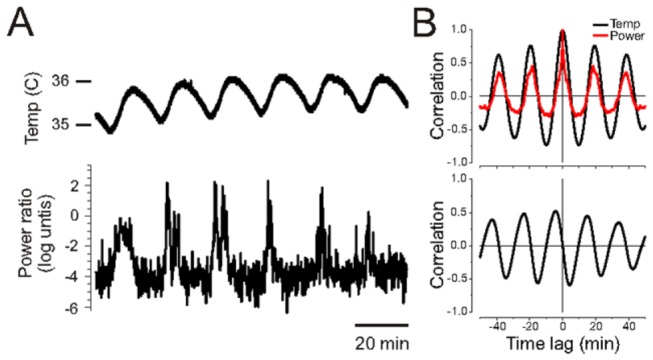
Spontaneous brain state alternations are coordinated with fluctuations in body temperature. A) Core temperature measurements (upper trace) and state alternations, as shown by fluctuations in theta/slow oscillation (4Hz/1Hz) power ratios in hippocampal LFP (lower trace), appear rhythmically coordinated over a long recording period. B) Autocorrelation function (top panel) of traces shown in A) demonstrate rhythmicity of both temperature (black) and power (red) fluctuations occurring at a similar period of approximately twenty minutes. Cross correlation function (lower panel) between temperature and power measures shows coupling between these rhythms with peak in temperature lagging behind that of power by slightly over 4 minutes.